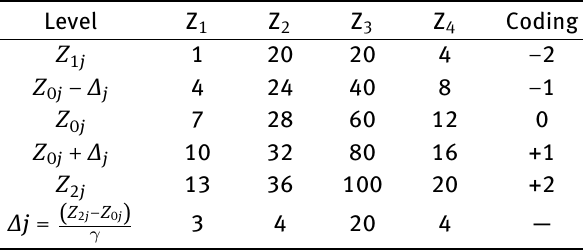
Table 3: Range of values for each test factor Level Grinding wheel Duty cycle (% ) Electrolytic current o r Grinding depth c t ( µ m) speed (m/s) a F Upper level 1 20 20 Lower level 13 36